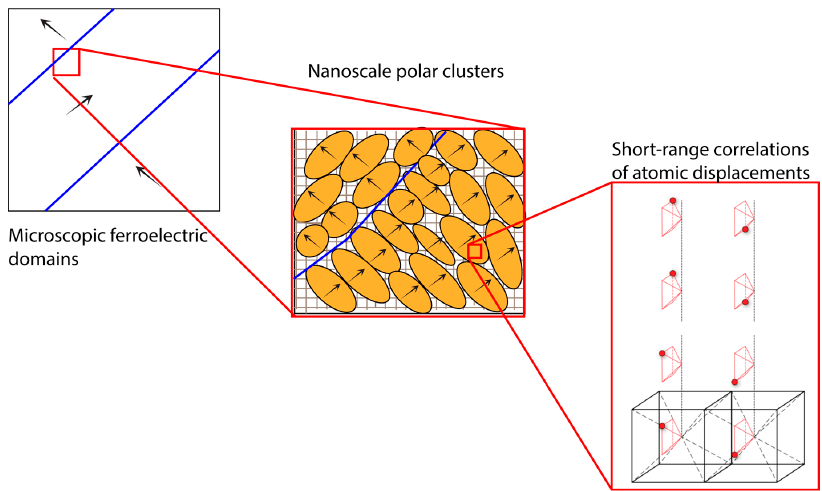
Figure 2. Schematic illustration of multi-level structural hierarchy in single-crystals of Pb-free piezoelectric materials. Application of external stimuli induces changes for one or more of the structural features.